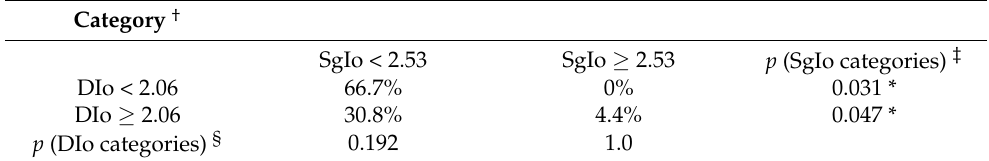
Table 6. Proportions of the 1,5-AG < 14 µ g/mL category stratified with the SgIo and DIo categories. Category † SgIo < 2.53 SgIo ≥ 2.53 p (SgIo categories) ‡ DIo < 2.06 66.7% 0% 0.031 * DIo ≥ 2.06 30.8% 4.4% 0.047